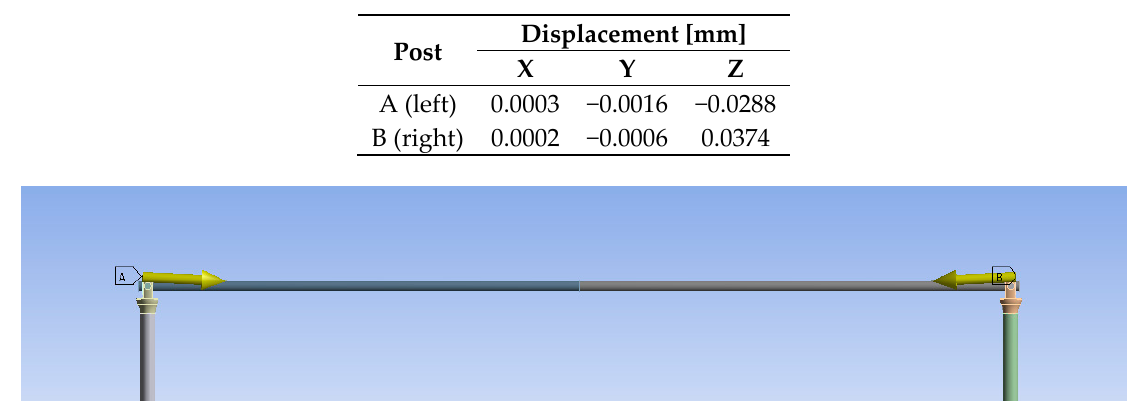
Table 3. Displacement of the strut end in each direction.